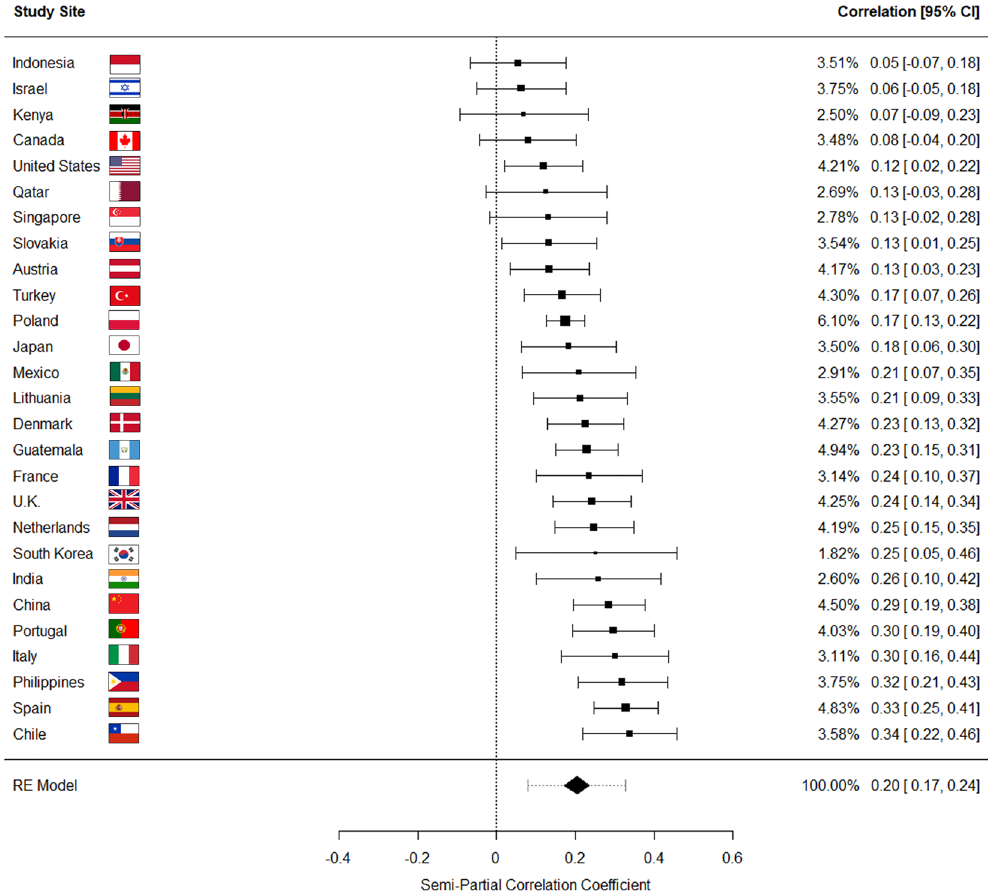
Figure 3. Results of a random effects, restricted maximum likelihood meta-analysis in which each study site was treated as a separate sample. The plot shows semi-partial correlations 54,55 between traditionalism and COVID-19 health precautions at each study site, after adjusting for the effects of the five identified suppressor variables in multiple linear regressions where health precautions were regressed on traditionalism and each of those five variables. Covariates were identical across study sites. Note that the semi-partial correlations indicate the variance in health precautions uniquely explained by the aspects of traditionalism separate from the five suppressor variables, and the effect sizes can be interpreted using the same metrics applied to product-moment correlations. See Fig. 1 for a description of how to interpret the forest plot. For the overall meta-analyzed point estimate, neither the 95% confidence interval nor the 95% prediction interval overlap with